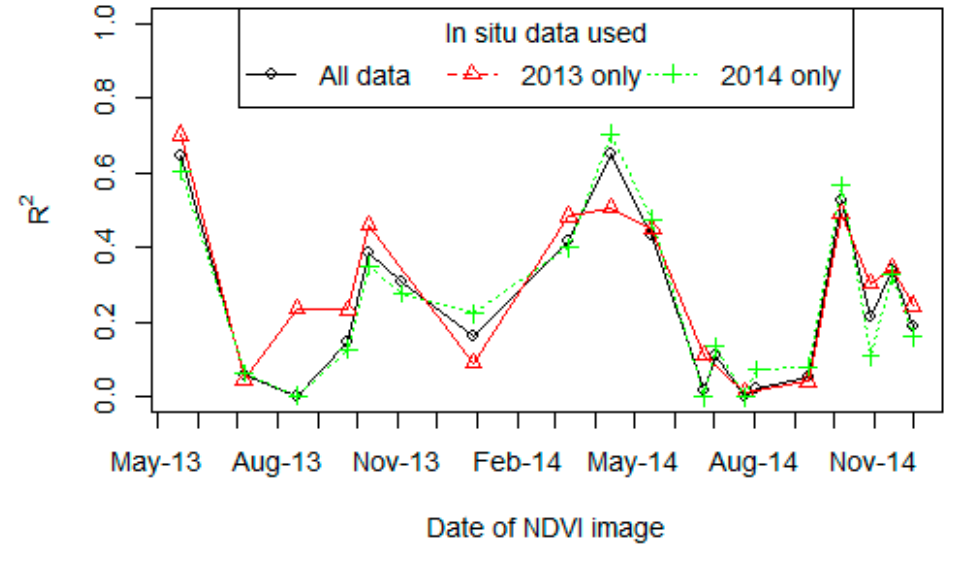
Figure 6. Time series of R 2 values for the regression of single date NDVI and in situ ANPP (g dry mass m − 2 year − 1 ) using in situ data from both years, 2013 only or 2014 only.